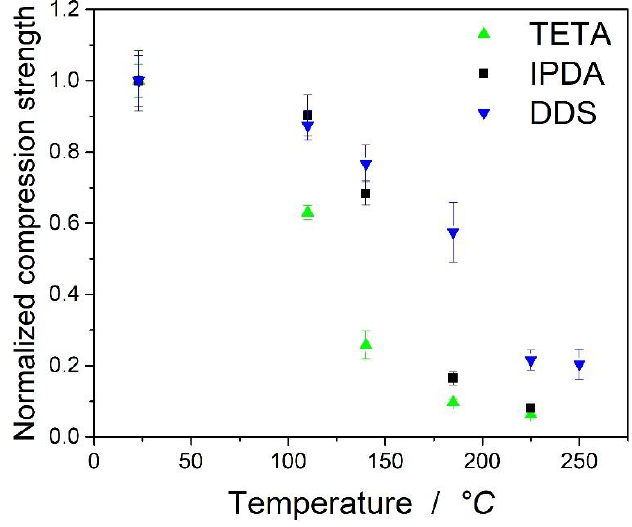
Figure 7. Normalized compression strength relative to the strength at room temperature.